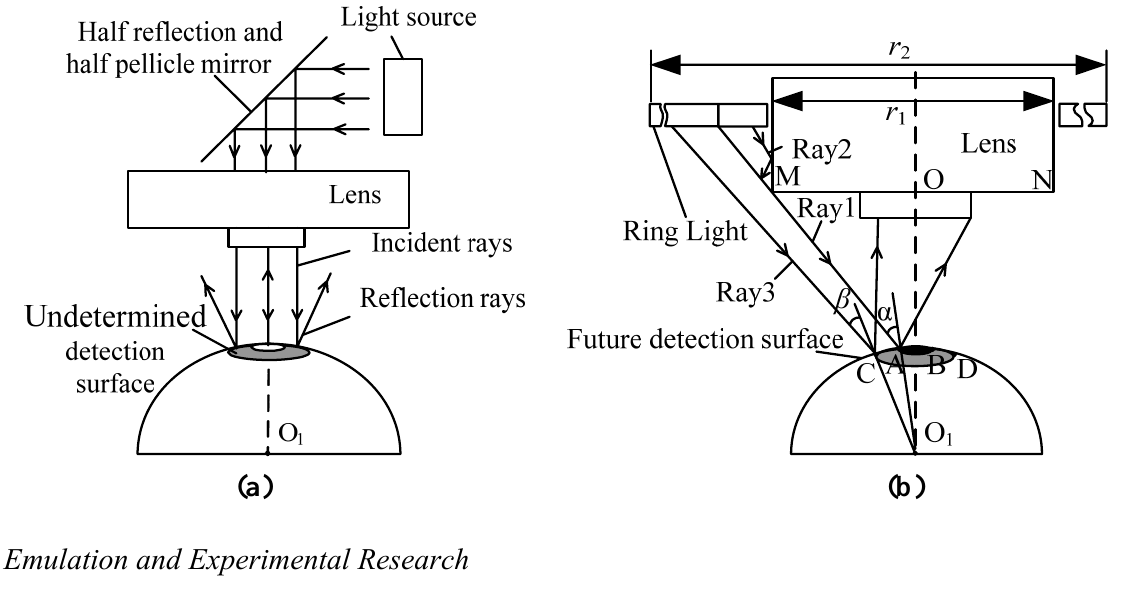
Figure 8. Light source design. (a) Coaxial light, (b) Ring light